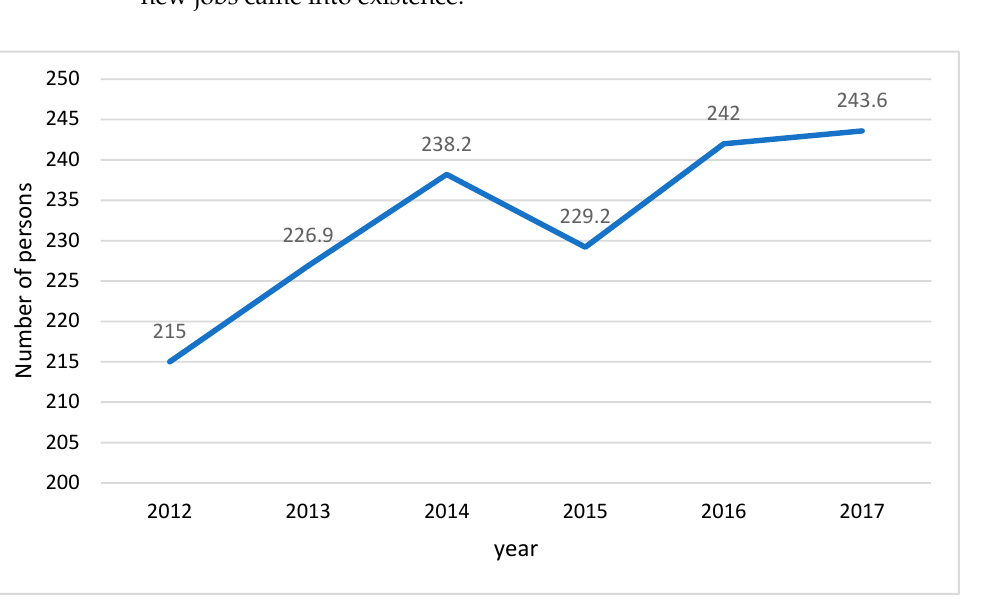
Figure 1. Total employment in the high-tech sector in the Czech Republic (in